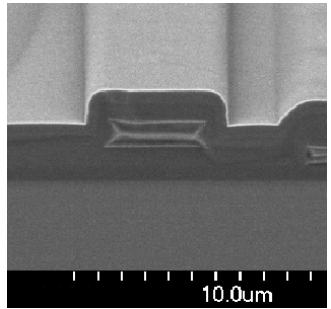
Figure 5. Section through a pressure sensor membrane (Trieu, 2011).